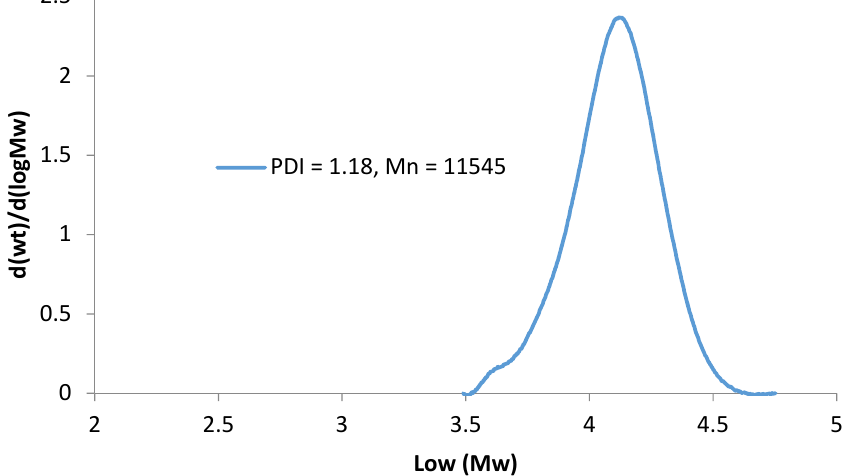
Figure 7. Gel Permeation Chromatography (GPC) analysis of the polymerization of PPEGMA via NMP.